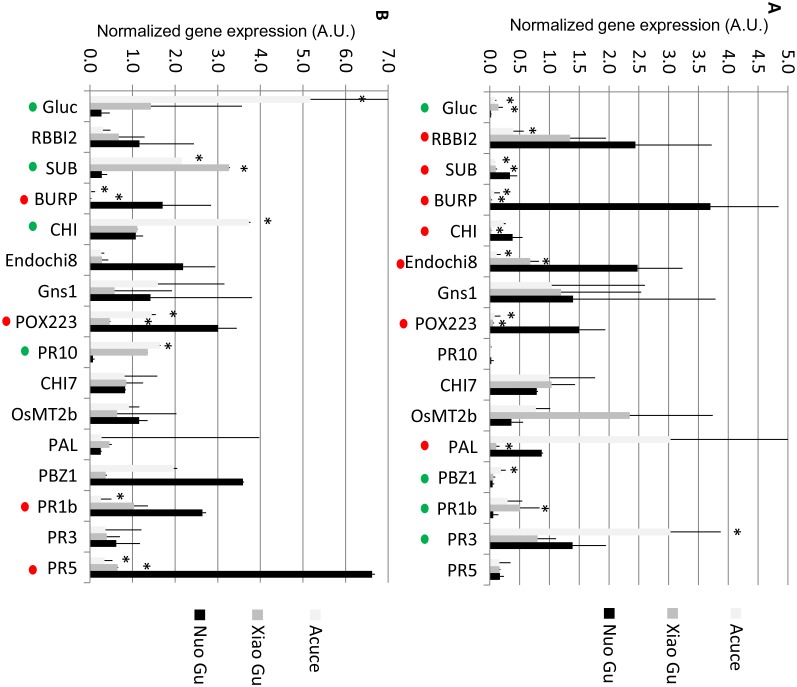
Constitutive and fungal-induced expression of pathogenesis-related genes in Yuanyang japonica and indica varieties.The expression of 16 pathogenesis-related genes was measured by RT-qPCR in the absence of treatment. (A) or 24 after inoculation by M. oryzae (isolate Guy11). In order to compare all genes together, all values for one gene were normalized with the average value of the considered gene for all measures. The values are the means and SD from four biological replicates. The japonica variety Nuo Gu was compared to the Yuanyang indica varieties Acuce and Xiao Gu. The ‘*’ denotes statistical differences (t-test; p<0.05) between Nuo Gu and the considered variety. A red and green dot indicates that Nuo Gu expression is higher and lower than either Acuce or Xiao Gu.